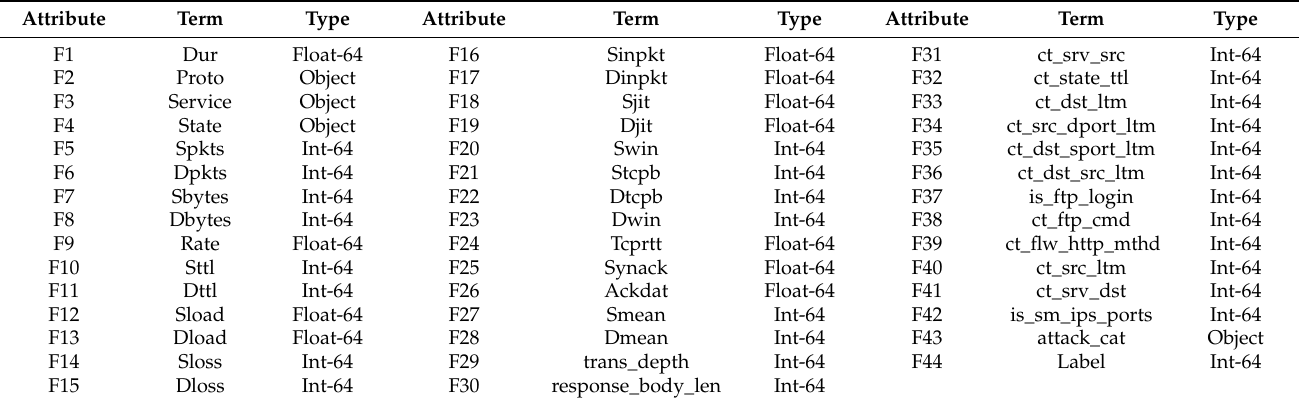
Table 3. UNSW-NB15 dataset 42